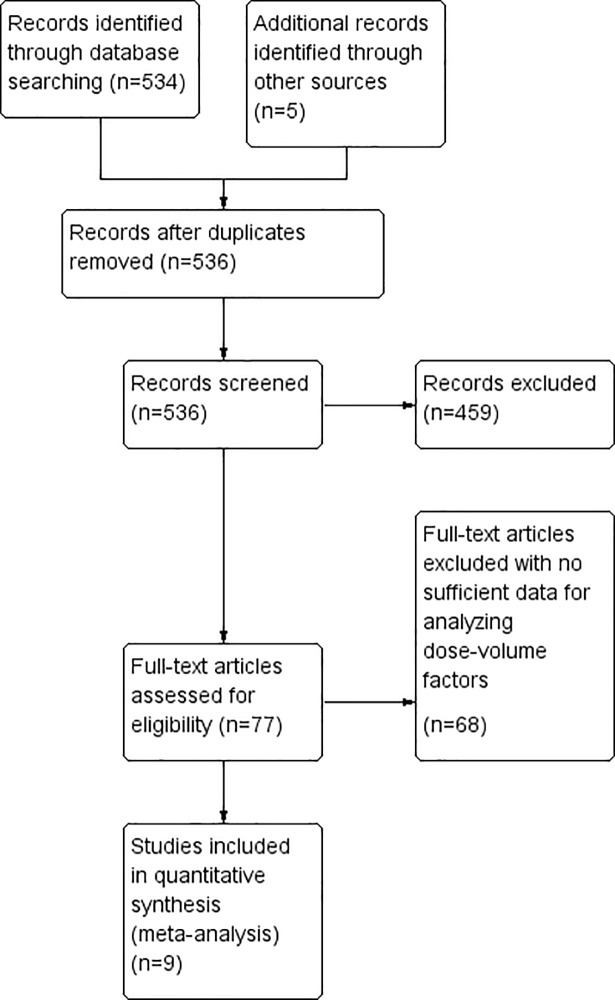
PRISMA flow chart depicting the study selection process.